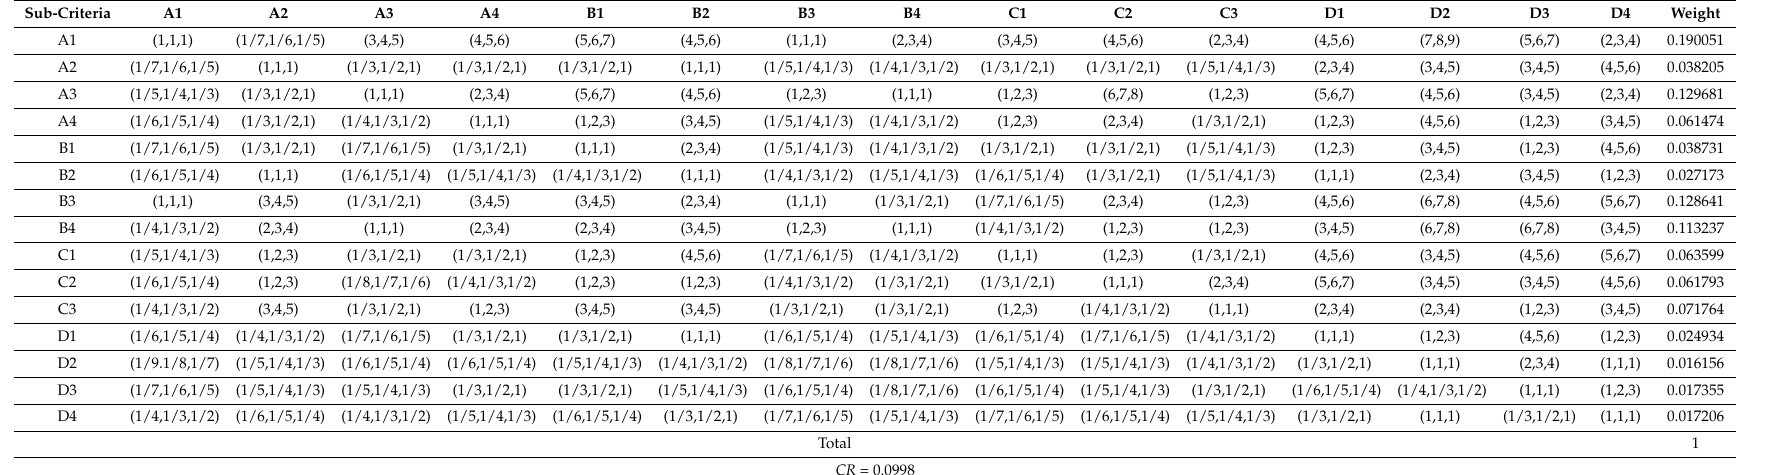
Table 10. Comparision matrix of S1 based on